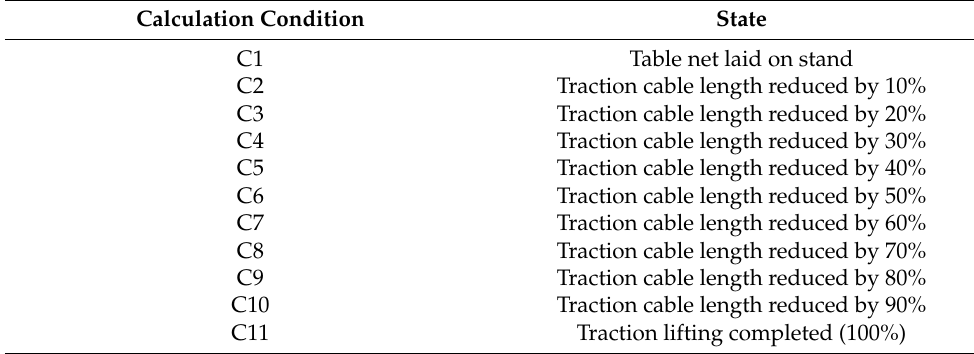
Table 6. Calculation conditions during synchronous equal proportion integral lifting